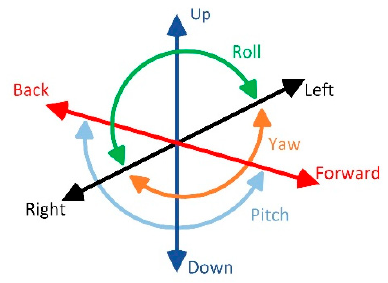
Figure 2. Drone possible movement scenarios.